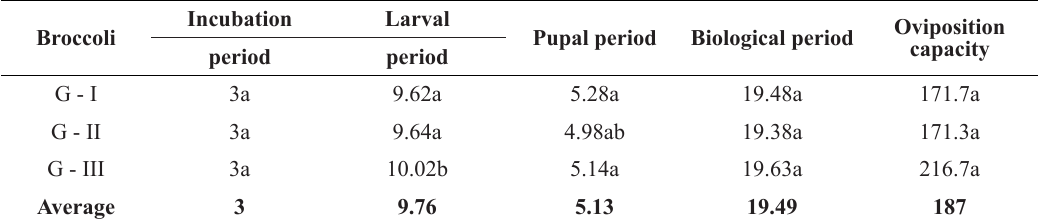
Table 1. Average of biological parameters of Plutella xylostella L., during three successive generations (G) in broc - coli, under laboratory conditions. March - August 2013. La Molina, Lima -